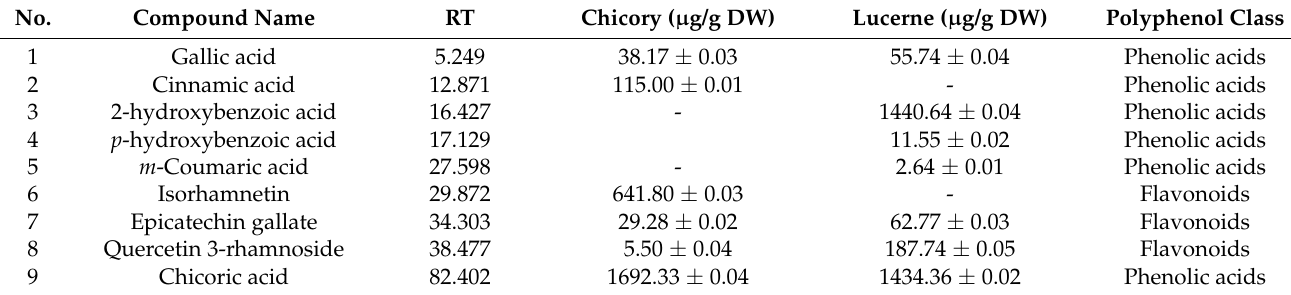
Table 4. Quantification of targeted polyphenols in chicory and lucerne by HPLC-PDA